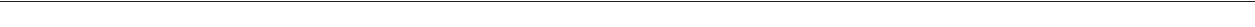
Fig. 1 Altered neuronal distribution during cortical development by piggyBac transposon mutagenesis. a Top: a schematic diagram of effects of somatic mutations in cortical development. While normal GRCs produce neurons that migrate normally to the cortex, RGCs that carry detrimental mutations may cause migration delay of their progeny. Bottom: early somatic mutation events lead to a large number of mutant cells carrying the same mutation through clonal expansion. b A schematic diagram of the PB-induced neuronal migration delay in the developing mouse cortex. The brains were electroporated with GFP (green) alone or with PB and PBase (red) at E14.5 and the distribution of cells was assessed at P10. c In mouse brains electroporated with pCAG-GFP (green, left panel) or PB (red, center panel) at E14.5, the labeled cells were primarily found in layer 2/3 of the cerebral cortex at P10. In contrast, an additional ectopic layer of cells was found beneath the cortex in brains electroporated with PB and PBase (right panel), this combination allowing the insertion of PB into the genome. Bar = 200 μ m. d Cell distributions in different brain regions of the cerebral cortex. Control pCAG-GFP: n = 4 animals; PB: n = 4 animals; PB + PBase: n = 6 animals. *: p < 0.05, Student ’ s t test. Error bars = s.d. e Arrest of GFP + cells by PB insertional mutagenesis. Brains were electroporated with pCAG-GFP, PB, and PBase at E14.5 and examined at P10. GFP and RFP double positive cells were observed not only in the cortex (arrowheads) but also ectopically in the WM (arrows). Bar = 100 μ m. f Neuronal identify of cells arrested in the subcortical regions. Many GFP (green) and RFP (red) double positive cells in the brain slices expressed the neuronal marker NeuN (magenta, arrows, upper panel) and layer 2 – 4 marker Cux1 (blue, arrows, lower panel) at P10. Brain slices were co-stained with DAPI (blue). WM, white matter. Bar = 100 μ